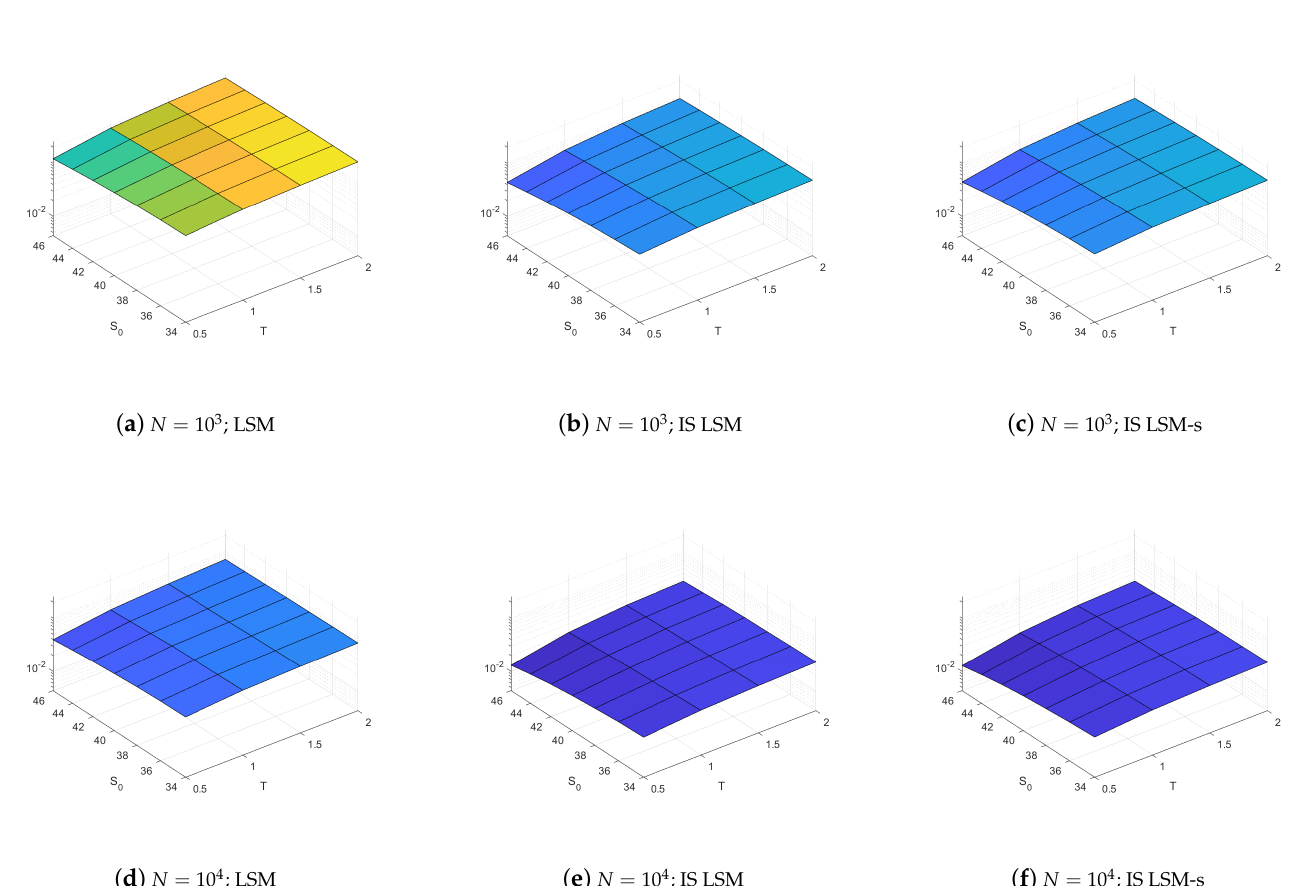
Figure 3. Standard deviation without and with optimal drift. Standard deviation results are calculated from a sample of R = 10 7 / N replications of the LSM and the LSM-s estimators. The left column illustrates results for the LSM without importance sampling, the center column LSM with importance sampling, and the right column LSM-s with importance sampling. The top row presents results for estimators using 1000 paths and the bottom row for 10,000